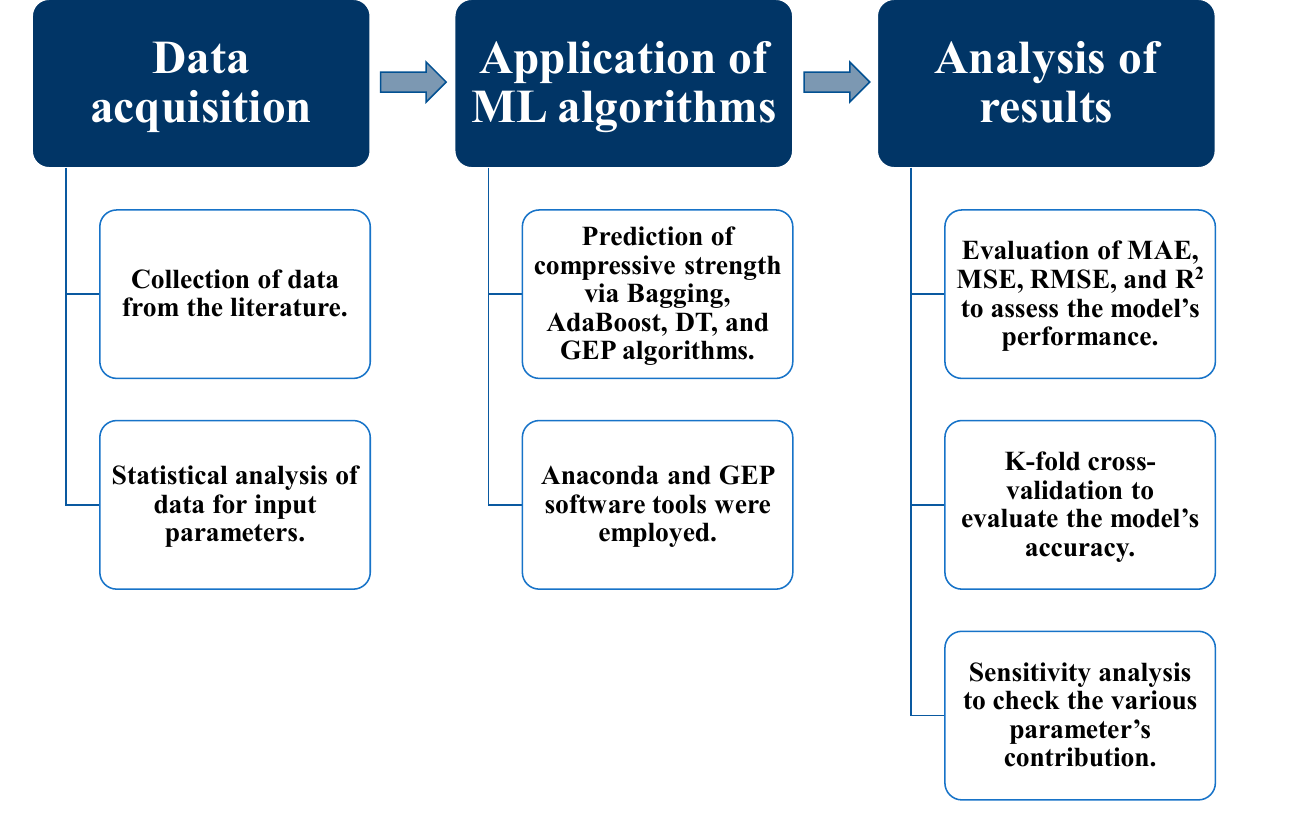
Figure 2. Research methodology flow chart.